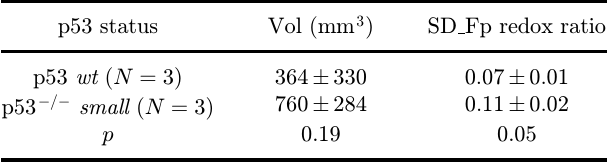
Table 1. Global average analysis results of size matched Table 4. Section univariate analysis results on the size